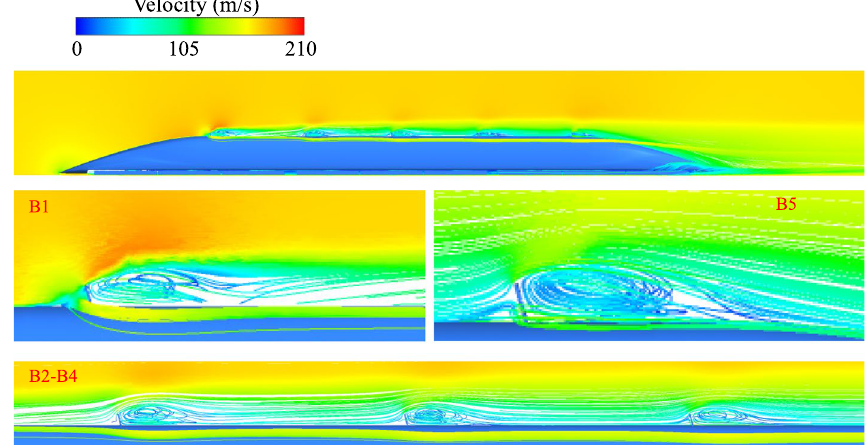
Fig. 12 The velocity distribution of longitudinal section of the